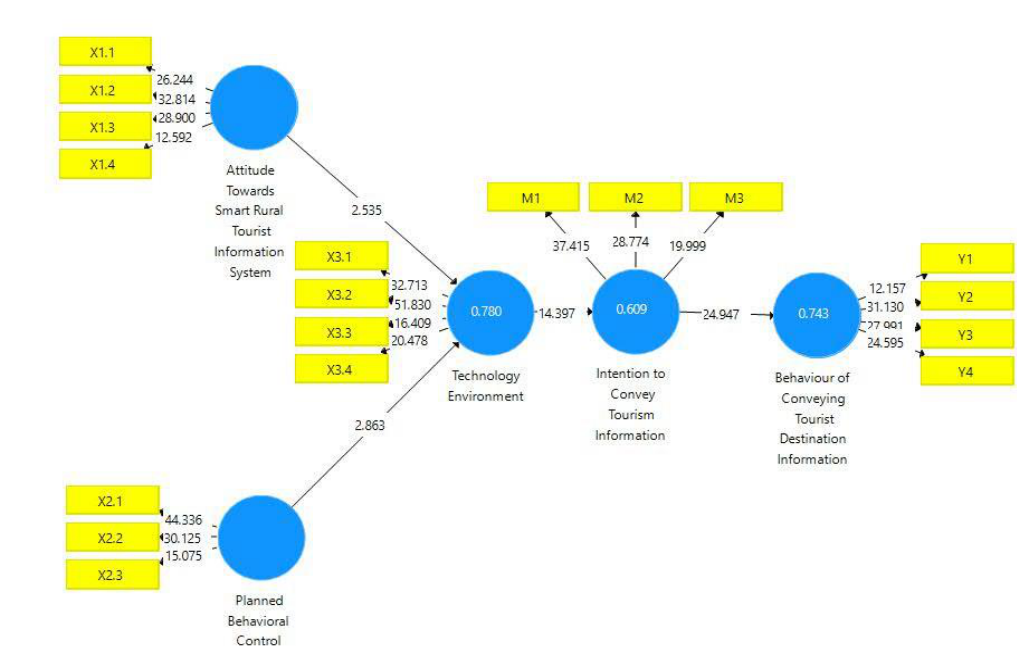
Figure 1: The Communities behavioral intention to convey information with SRTIS